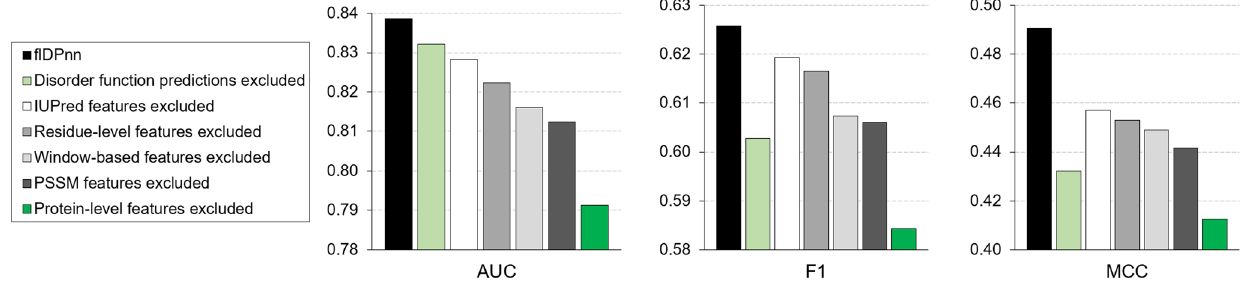
Fig. 3 Ablation analysis of the fl DPnn predictor on the test dataset. Black bars show results for the fl DPnn model. Green bars quantify predictive quality where one of the two major innovations (disorder functions predictions in the pro fi le and protein-level feature encoding) is excluded. Gray bars show the performance where one of the architectural elements that are often utilized by the current predictors (residue-level and window-level feature encoding) is excluded. AUC (area under the ROC curve); MCC (Matthews correlation coef fi